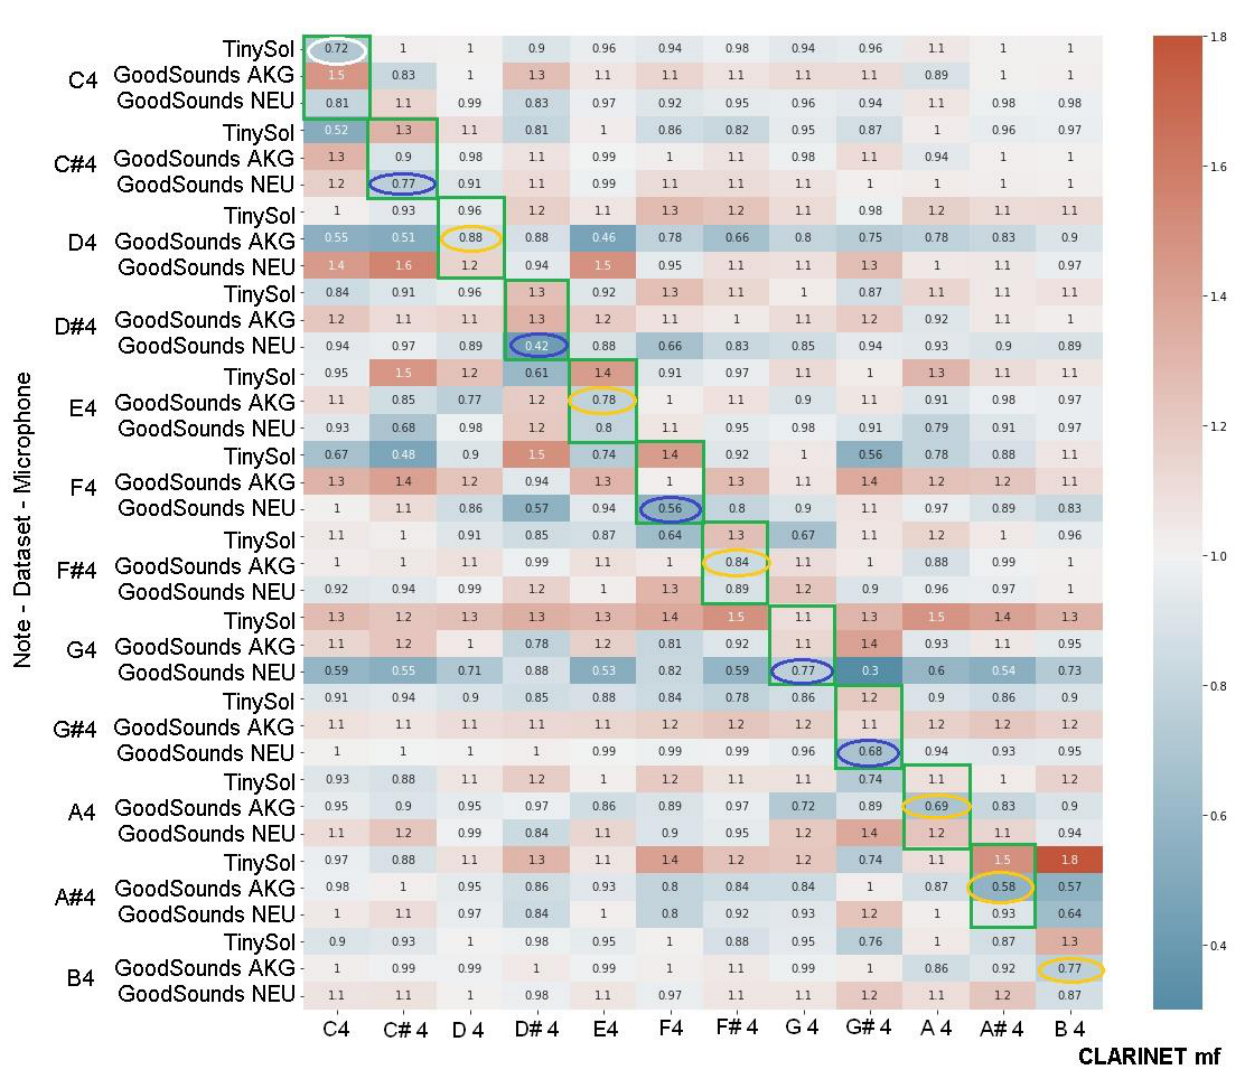
Figure 5. Patterned distance between musical sounds for Clarinet to reference sounds, according to several data sets. The circles of colors represent the shortest distance between the three dynamics.